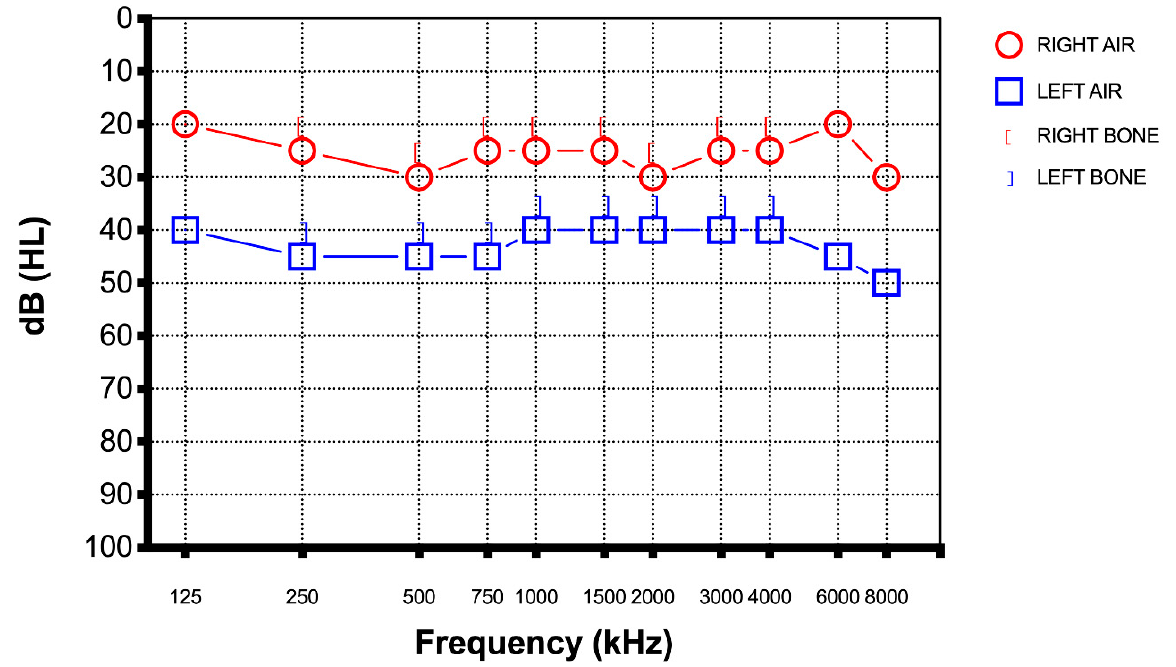
Figure 4. Case 2 pure tone audiometry after therapy showed an almost full recovery of the hearing loss.